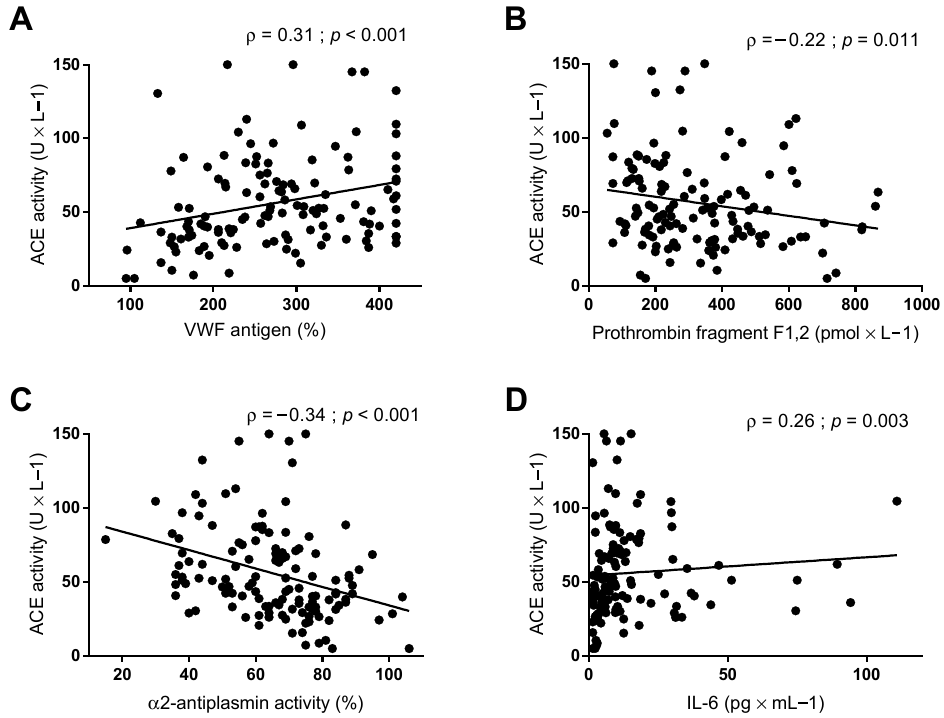
Figure 3. Correlations between plasma levels of angiotensin-converting enzyme (ACE) and plasma levels of ( A ) Von Willebrand factor (VWF) antigen, ( B ) prothrombin fragment F1,2, ( C ) α 2-antiplasmin, and ( D ) interleukin-6 (IL-6). Correlations are assessed by Spearman’s Rho.